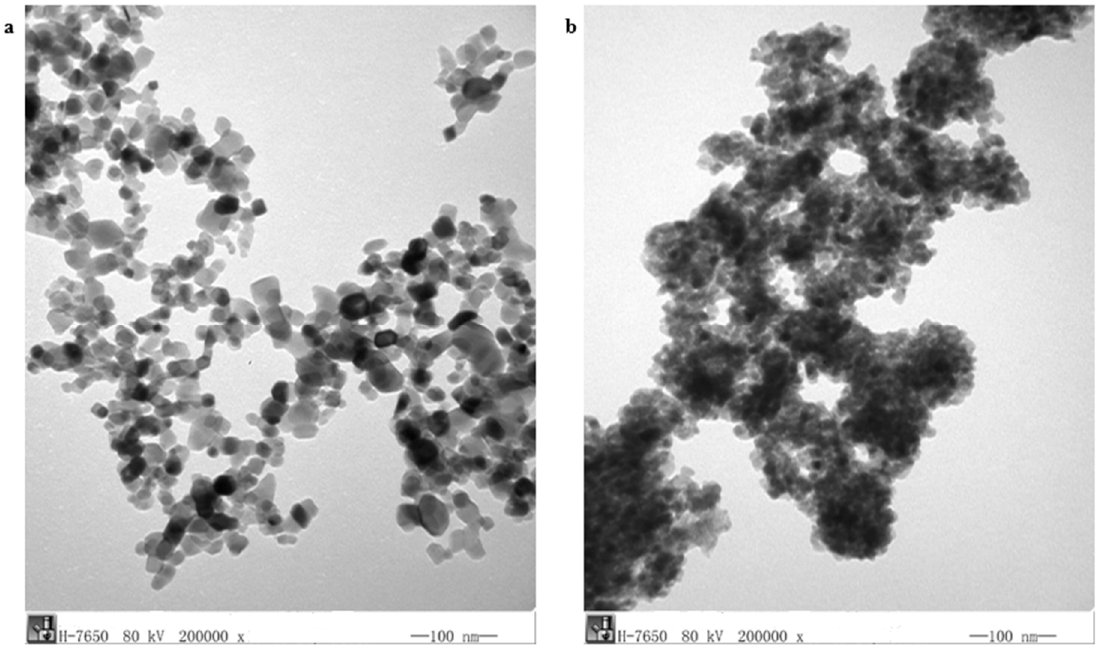
Figure 4. TEM image of ( a ) TiO 2 nanoparticles and ( b ) N-doped TiO 2 nanoparticles.